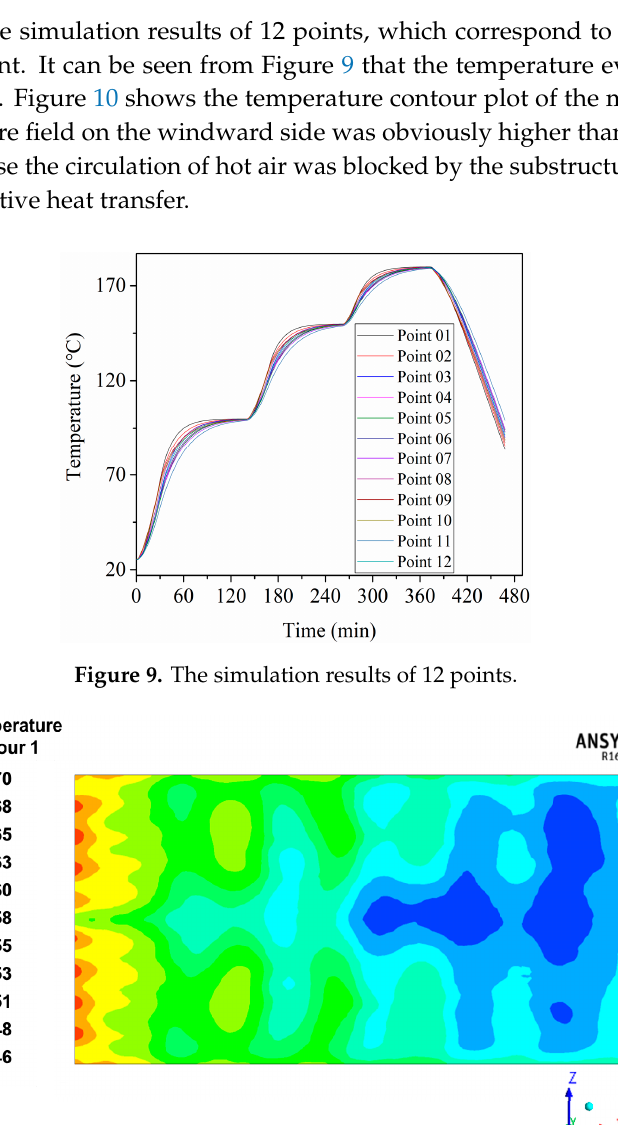
Figure 8. Boundary conditions of the autoclave.